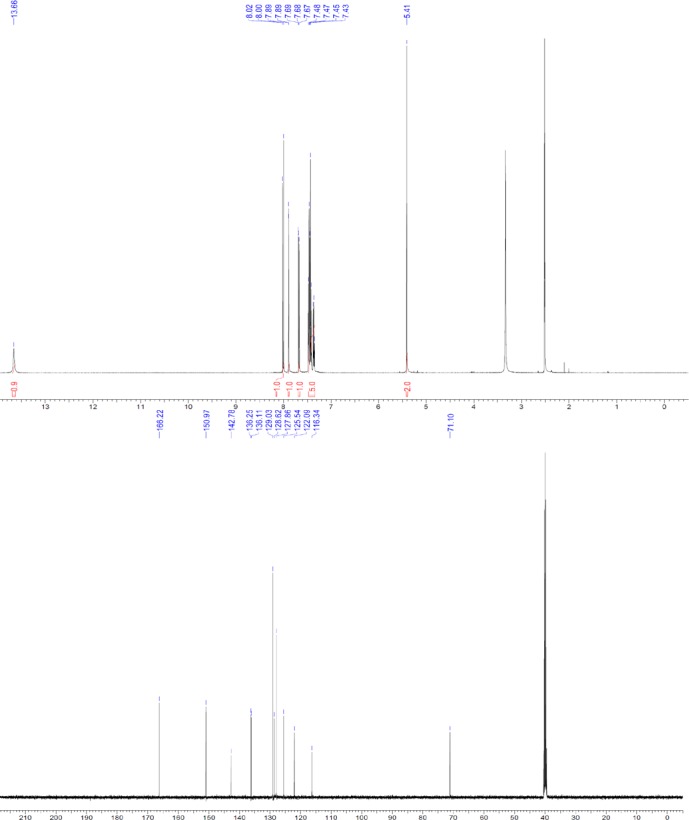
1H and 13C NMR of compound 3e.